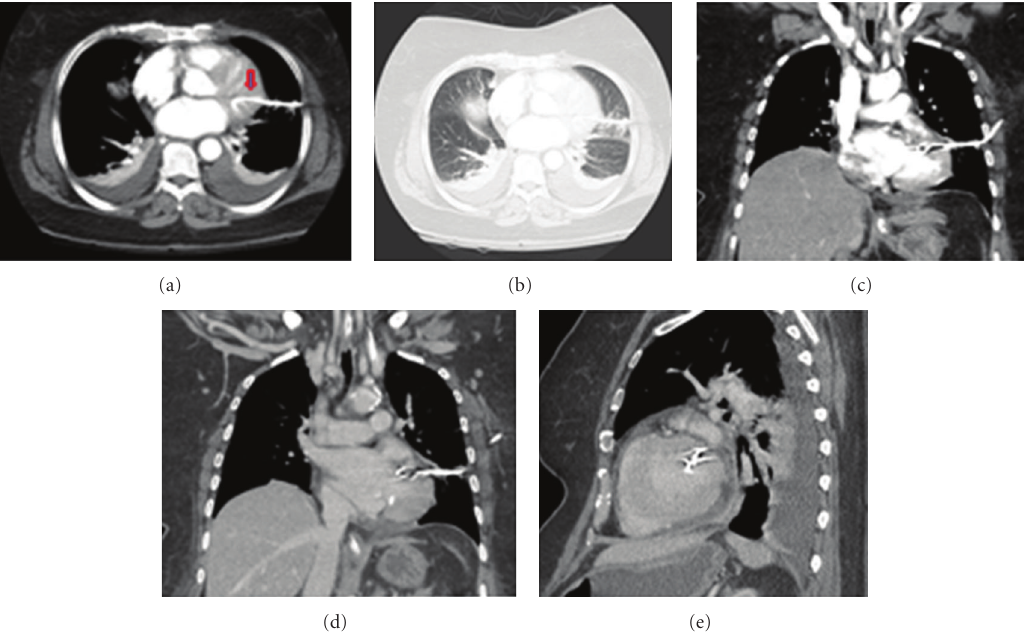
Figure 29: It shows a portable chest radiograph on an intensive care patient that developed pleural e ff usions. A chest drain was placed to drain the left-sided pleural e ff usion. Bright red blood was obtained from the tube. A CT scan (Figures 28 and 30) obtained immediately revealed the tip of the catheter had entered the left ventricle. The patient was immediately taken for cardiac surgery and the tube was removed without complications.